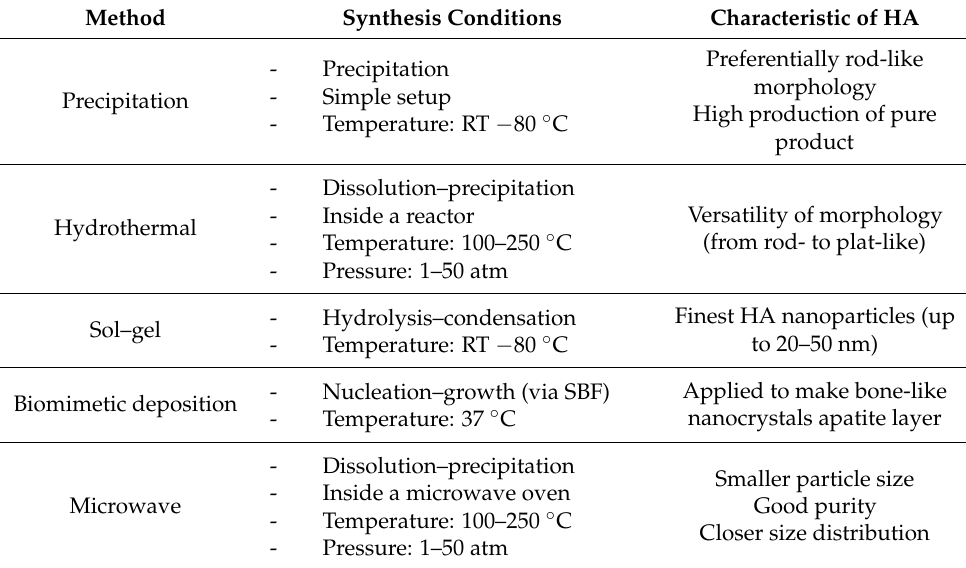
Table 2. Methods of synthesising hydroxyapatite